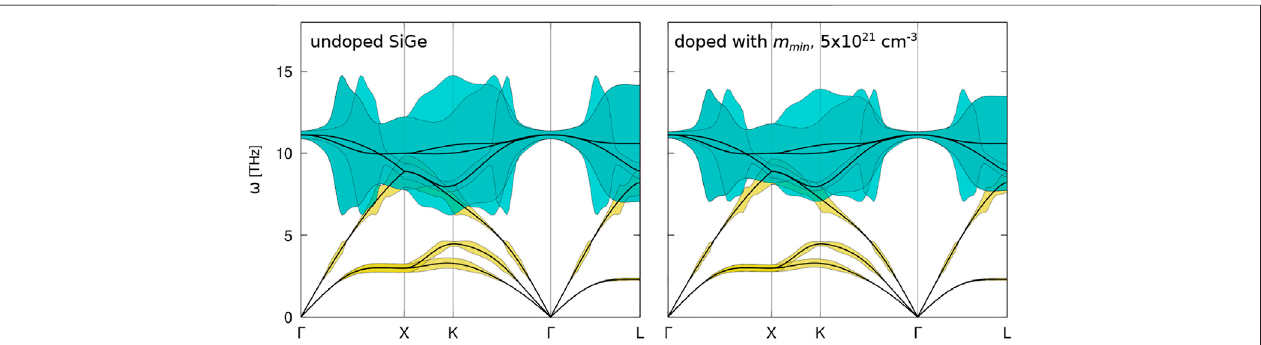
FIGURE 5 | Phonon dispersion of SiGe undoped (left) and doped with fi ctitious species of mass 60.217 a. u. (right) . The linewidth (inverse relaxation time) of acoustic and optical modes is represented in yellow and cyan, respectively. For better visual presentation, the value of the linewidth of optical modes has been divided in